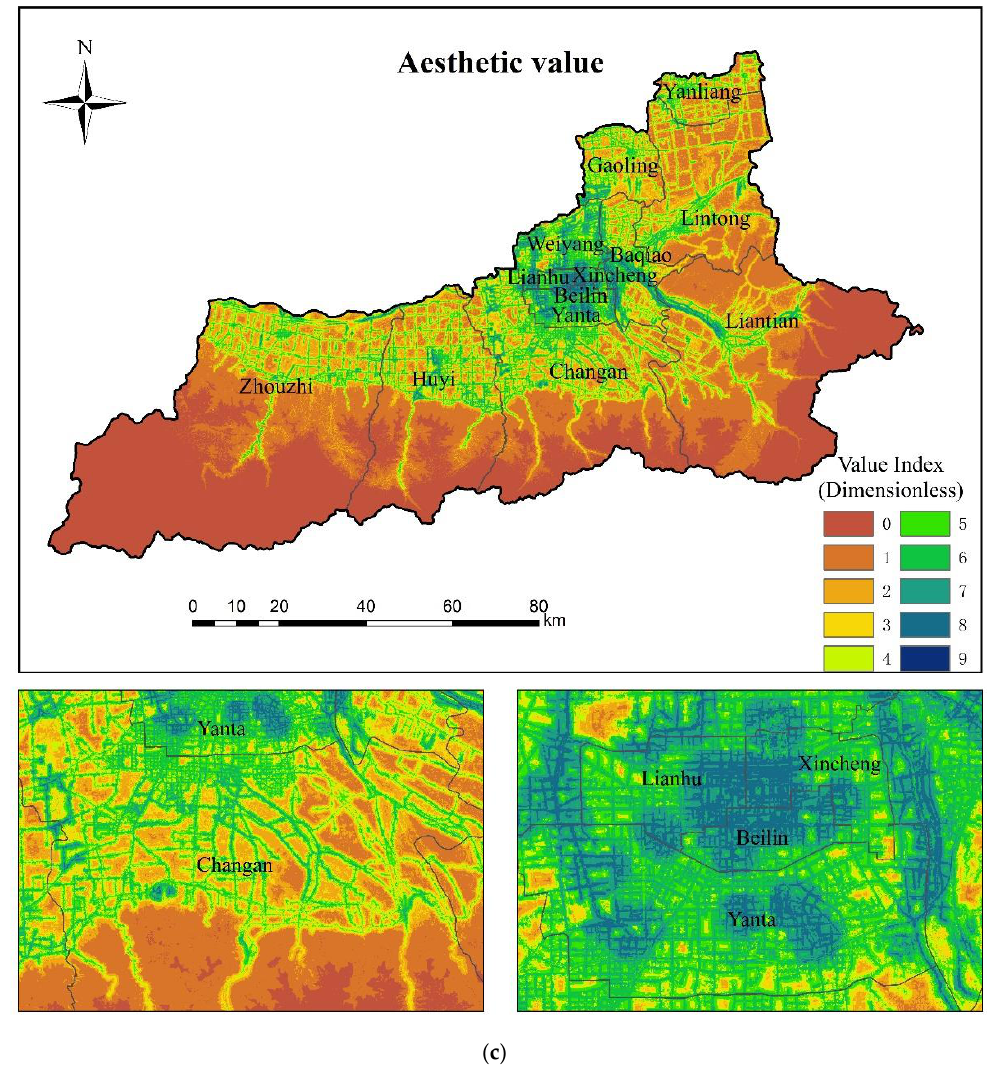
Figure 4. The VI map of CES. ( a ) Recreation VI map. ( b ) Historical VI map. ( c ) Aesthetic VI map.